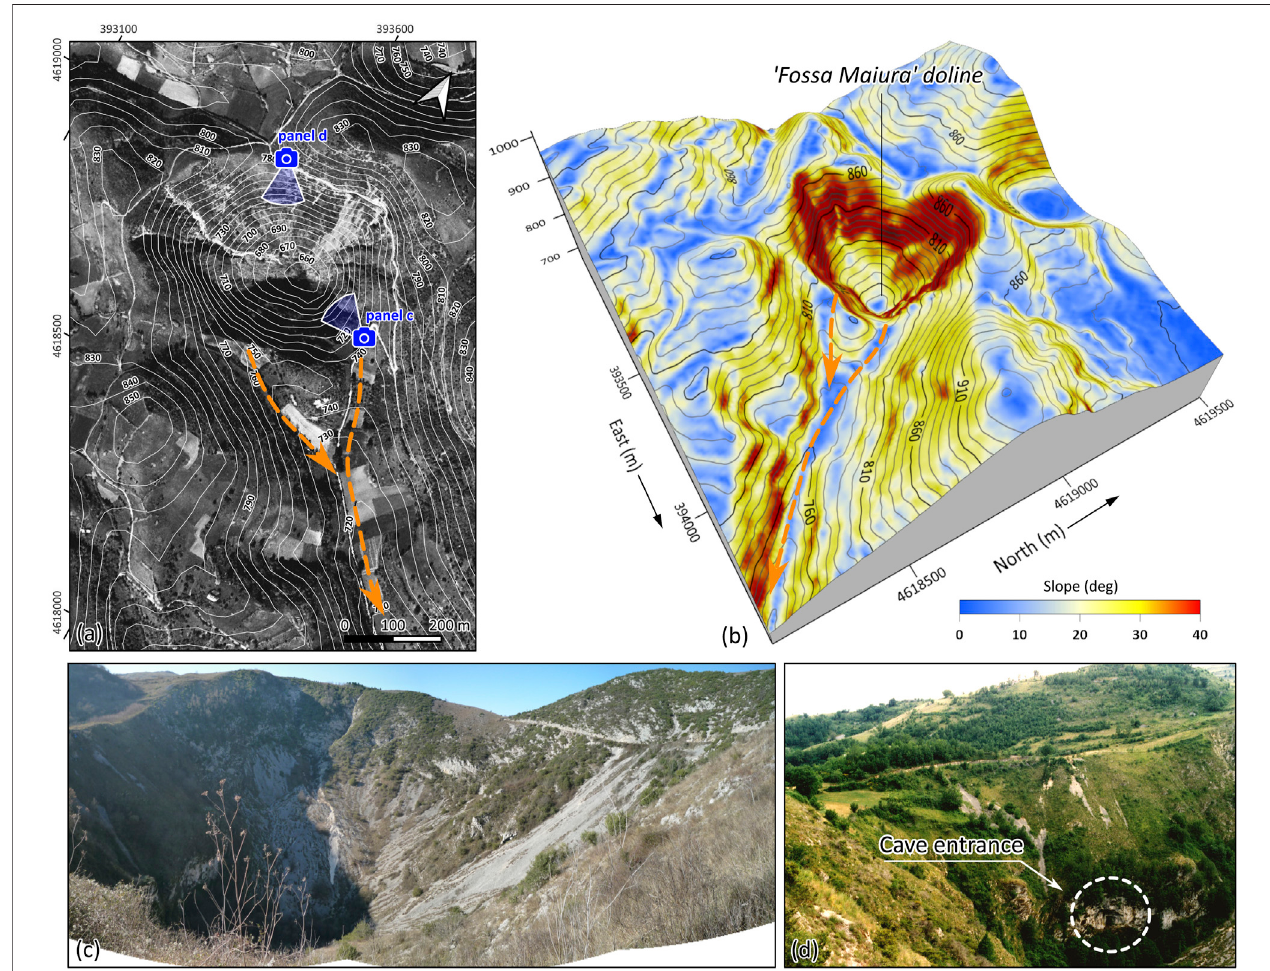
FIGURE 6 | Fossa Maiura doline (the dashed blue rectangle in Figure 4A ). (A) Black and white orthophoto with the indication of dry valleys (the dashed orange arrows) (B) Three-dimensional sketch with the slope angle. (C) Panoramic view. (D) Indication of the cave entrance along the doline fl ank (the picture location and orientation are in panel